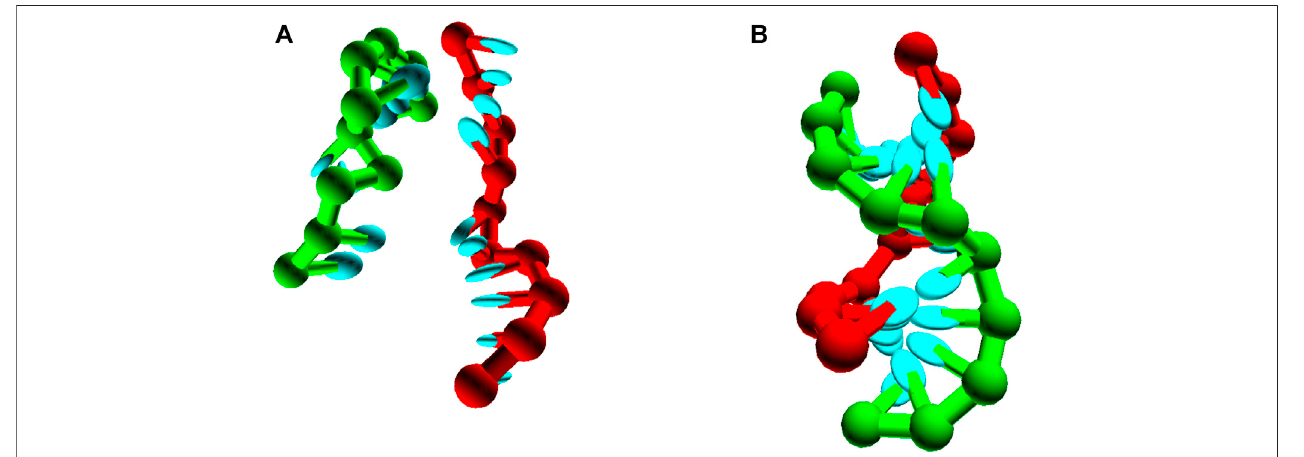
FIGURE 9 | Pseudoknot unbound (A) and bound (B) states, for seqeunces 3 ′ -AGCTTCCATG-5 ’ /3 ′ -AAGCTCATGG-5 ’ .